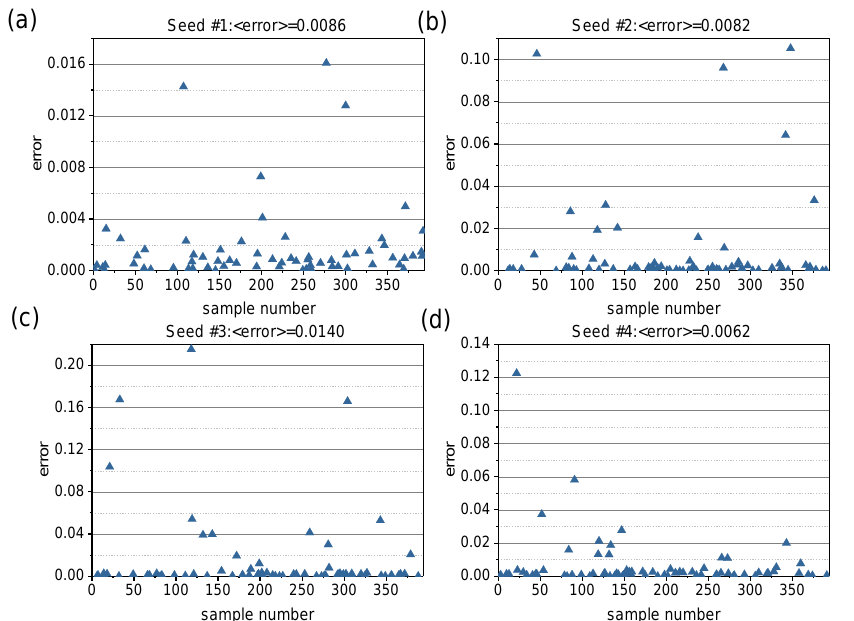
Figure 7. The distributions of errors for the different random seeds: ( a ) Seed#1:<error> = 0.0086; ( b ) Seed#2:<error> = 0.0082; ( c ) Seed#3:<error> = 0.0140; ( d ) Seed#4:<error> = 0.0062.